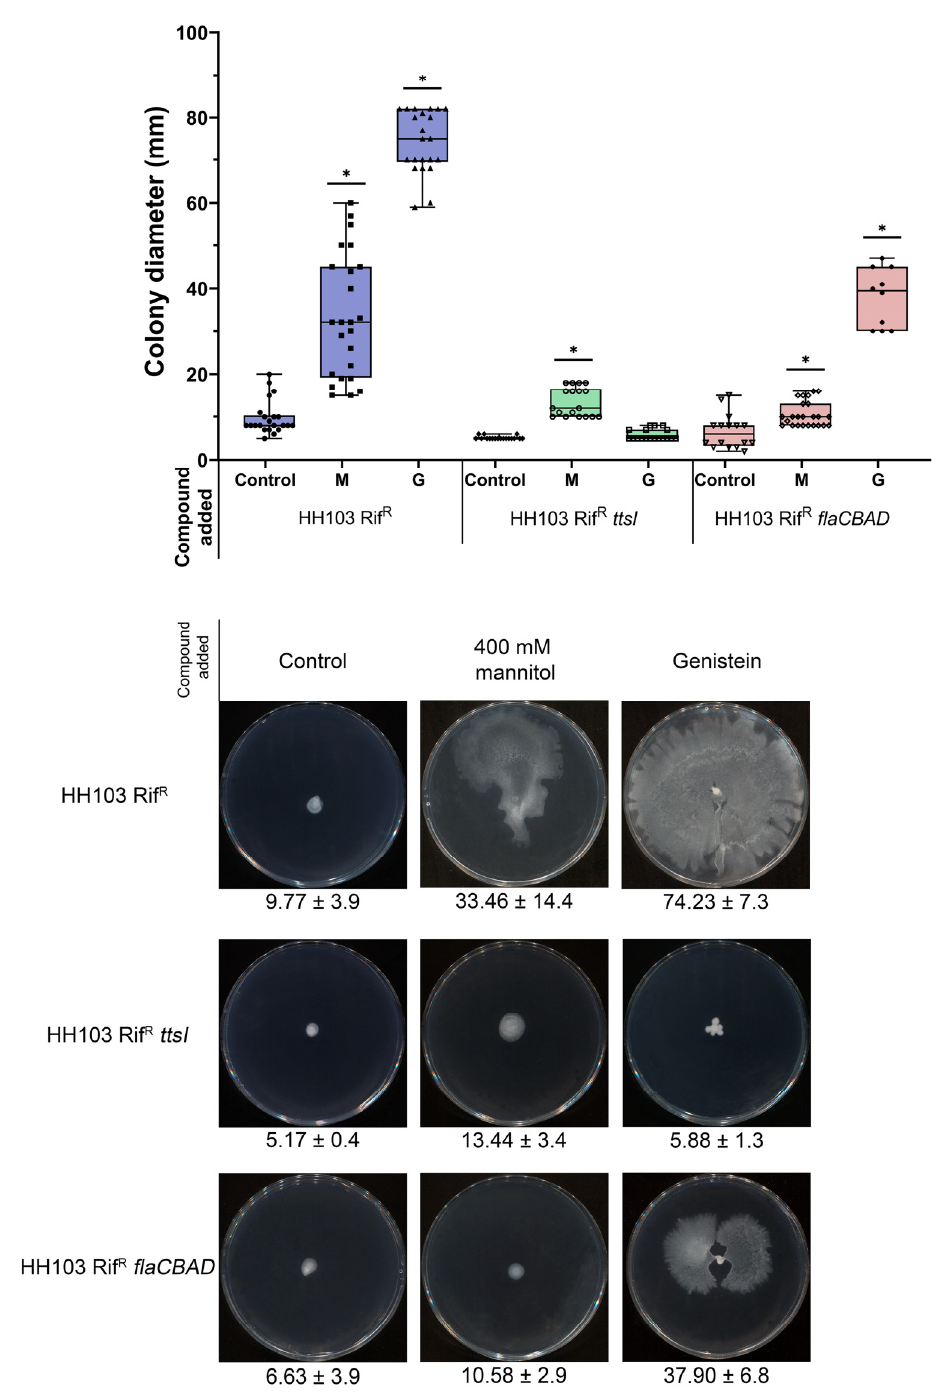
Figure 5. Surface motility of S. fredii HH103 and its ttsI and flaCBAD mutant derivatives in MM in the absence (Control) or presence of 400 mM mannitol (M) or 3.7 µ M genistein (G). All data points are shown in box and whisker plots from at least three biological replicates performed with two technical replicates. Values under images represent the average and standard deviation of migration (given in millimetres and determined as described in the text). For each strain, asterisks (*) indicate a significant difference from the corresponding control sample using the non-parametric test of Mann–Whitney, α =